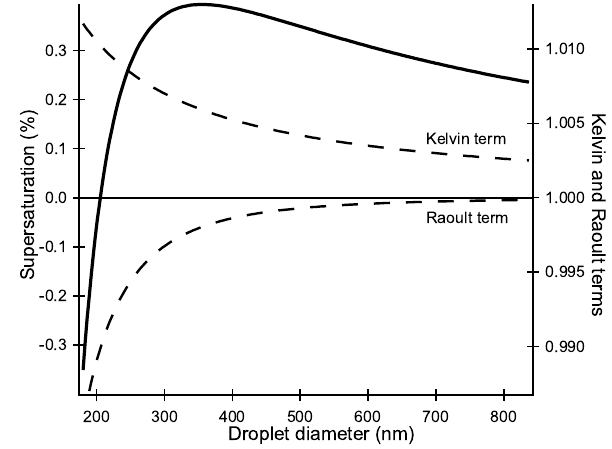
Fig. 1. Water supersaturation as a function of droplet size for a 40nm dry particle. Kelvin and Raoult terms are shown with the dashed line in the right hand side scale.